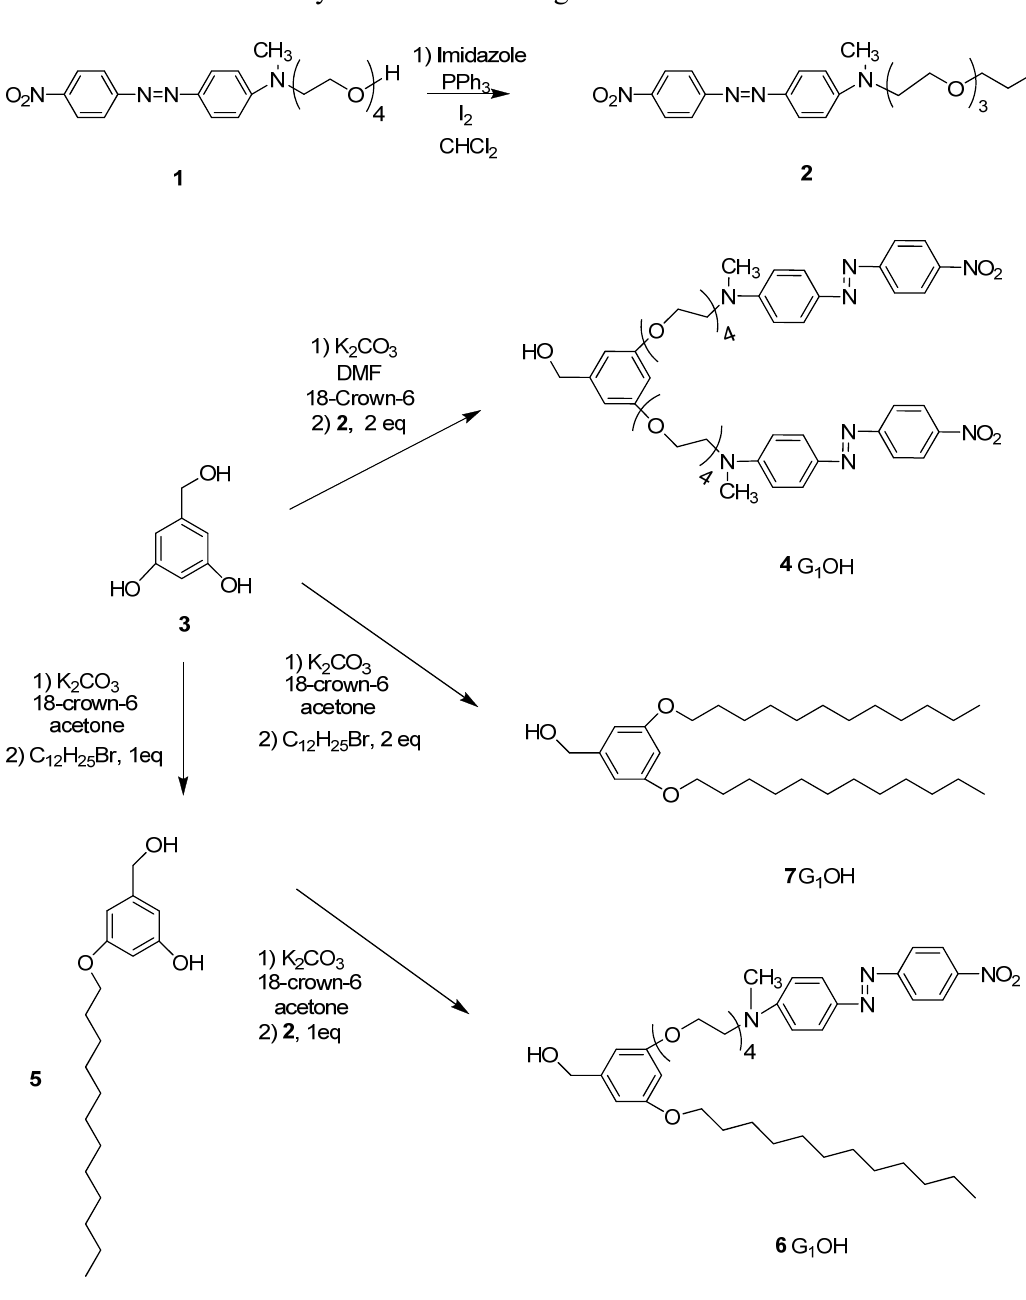
Scheme 1. Synthesis of the first generation dendritic